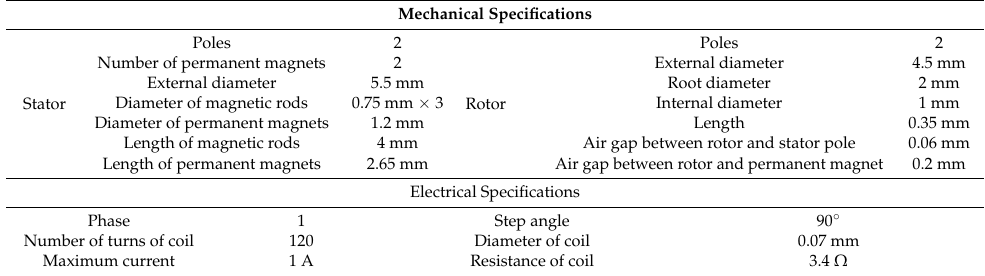
Table 1. Specifications of the micro, axial-flux, single-phase switched reluctance